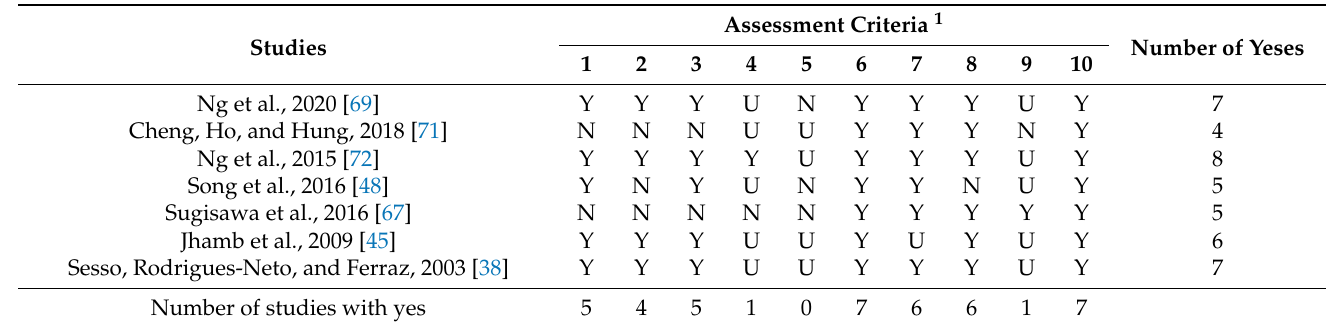
Table 2. Methodological quality of longitudinal studies.